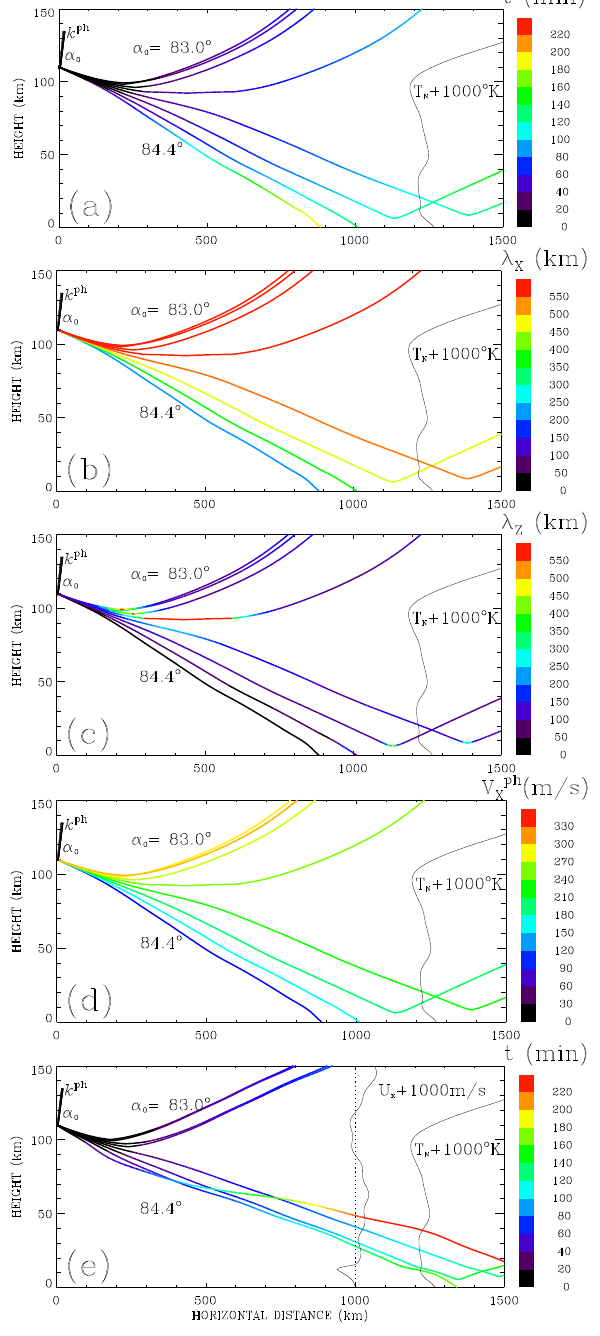
Fig. 1. Ray paths for 40-min gravity waves ( a-d ) in a stationary MSIS90 model atmosphere and ( e ) for a simulated wind profile, U ( z ). The rays are colour-coded to show the values of different parameters ( t , λ , λ , V xph ). The neutral temperature T ( z ) and wind U ( z ) profiles are shown using the abscissa with origin shifted and scale units in °K and m/s, respectively.